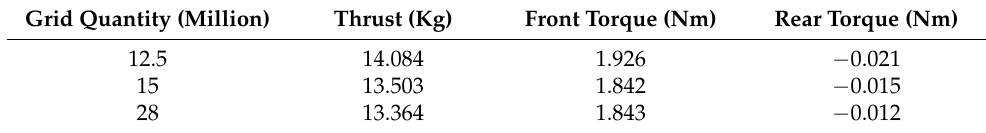
Table 2. Rotor Thrust and Torque Under Different Grid Quantities.